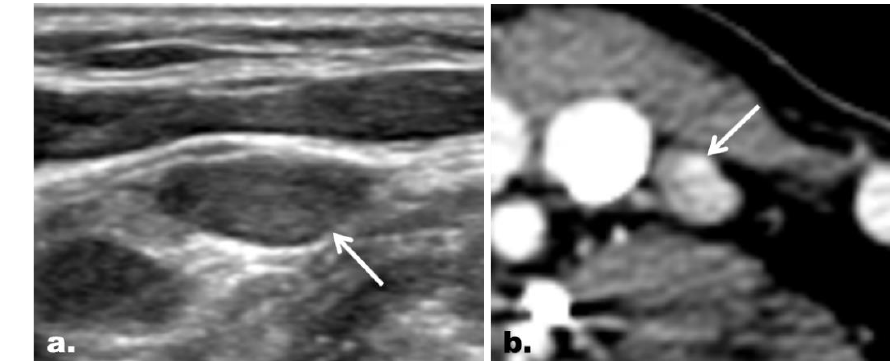
Figure 2. Representative case of correct reclassification of a US indeterminate LN with the addition of CT in a 48-year-old woman with PTC. ( a ) On US, an ovoid LN (arrow) with neither echogenic hilum nor suspicious feature was noted at the left neck level IV. The LN was classified as an indeterminate LN on US. ( b ) The LN, however, was shown to have a focal strong contrast enhancement (arrow) on CT, which led to correct reclassification of the LN as a suspicious LN. The final diagnosis based on FNA turned out to be metastasis. Correct changes in the classification were made in 5.1% (14 of 274) of the LNs enrolled, and the addition of CT helped identify additional metastasis in 6.2% (14 of 225) of the patients enrolled.